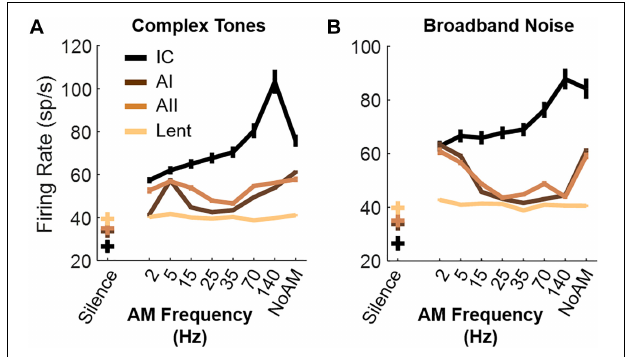
FIGURE 4 | Multiunit recordings of auditory (AI, AII, IC) and non-auditory (Lent) neurons. (A,B) Average firing rate in response to AM complex tones (A) and AM broadband noise (B) . Lines display average +- standard errors. N = 8 C57BL/6JRj female mice, 5–8 weeks old (JANVIER Labs). Brief summary of the protocol: surgery of mice (craniotomy) was done under Ketamine (190 mg/kg) and Xylazine (4.5 mg/kg) anesthesia. Recordings were done under Isoflurane (0.8–1% isoflurane in a flow rate of 0.2 L/min of 95% O 2 ) anesthesia 1 h after the IP injection. Using the stereotaxic coordinates (Paxinos and Franklin, 2019) and knowledge of vasculature, a matrix of 4 electrodes each containing 8 recording sites (Buzsaki32-CM32, Neuronexus, United States, cortical structures) or 32-channel laminar electrode (NeuroNexus, subcortical structures) was implanted in the primary auditory cortex (AI), the secondary auditory cortex (AII), the central nucleus of the Inferior Colliculus (IC) and the Lateral part of the entorhinal cortex (Lent). The high frequency signal (0.3–10 k Hz) acquired by the electrophysiology system (OmniPlex, Plexon Inc., United States) contained the extracellular action potentials of neurons. In AI and AII, the recording depth was 400–700 µ m, corresponding mostly to the layer V of the cortex (Chang and Kawai, 2018). In all areas, responses to 30 repetitions of AM noise and AM complex tones (for each AM rate) or 180 s of silence were recorded.